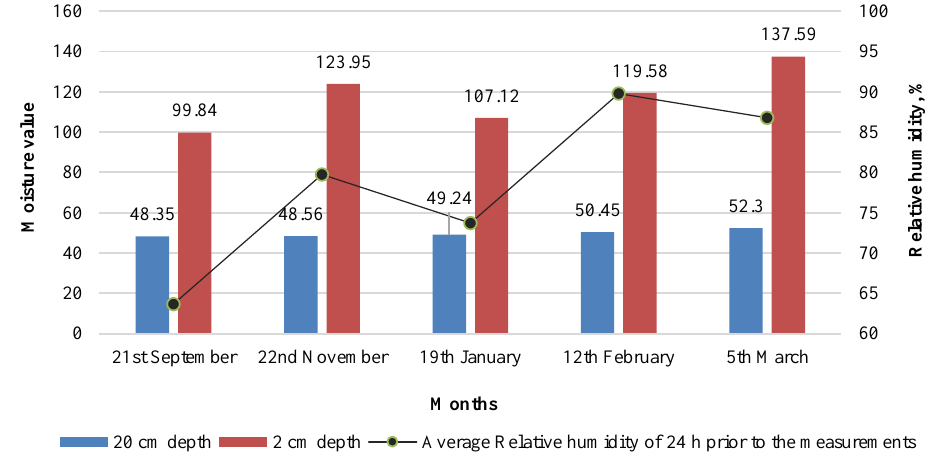
Fig. 7. Average values of the wall moisture measurements and outdoor relative humidity In Fig. 8 the correlation between the outdoor relative humidity and wall moisture is presented. The correlation observed is good for 2 cm depth and little less for 20 cm depth.